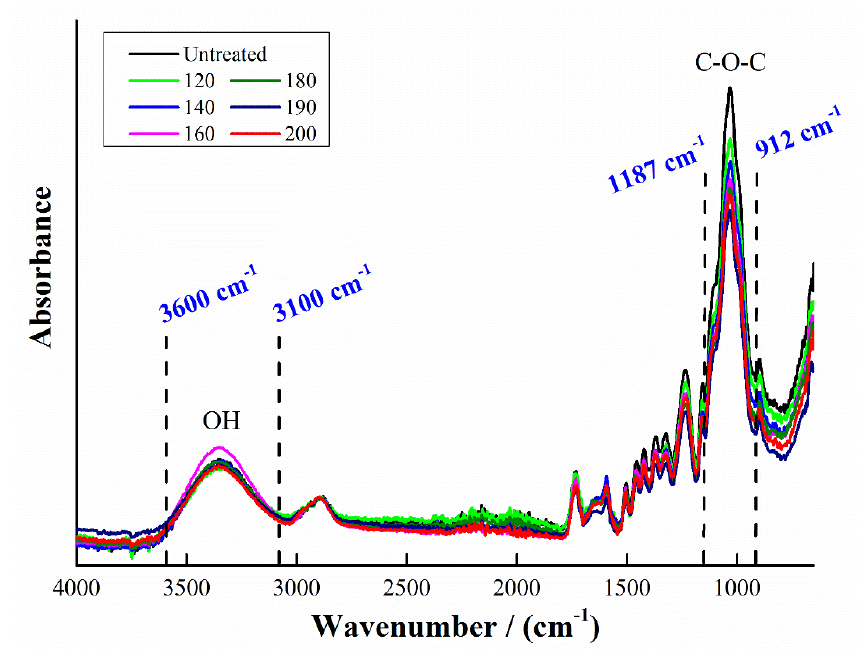
Figure 13. FTIR spectra of beech wood after heat treatment at 120–200 °C.